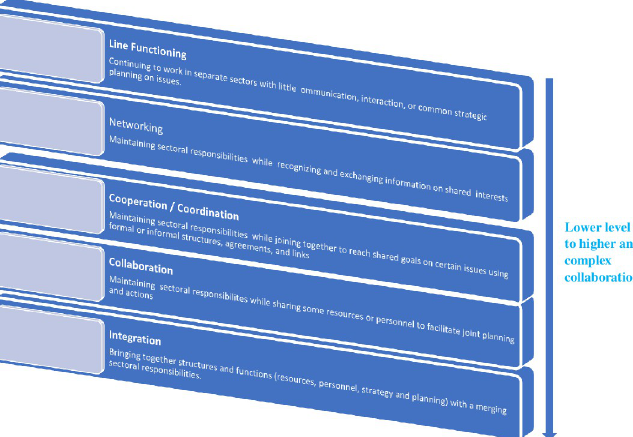
Fig 1. A continuum of multisectoral collaboration. Adopted from Harris and Drimie [33]; Himmelman [34,35].